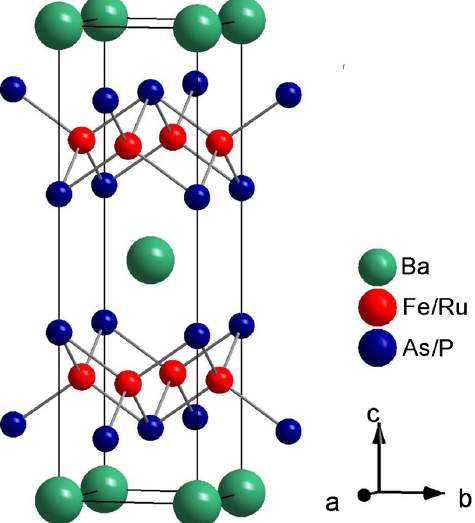
ð As P Þ 2 0 : 82 0 : 18 2 show no transition from a nodal to a nodeless state in the underdoped regime.